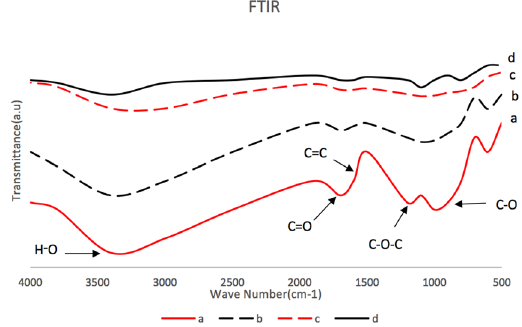
Figure 2. FTIR spectra of ( a ) GO, ( b ) r-GO-31, ( c ) r-GO-19, ( d ) r-GO-9.